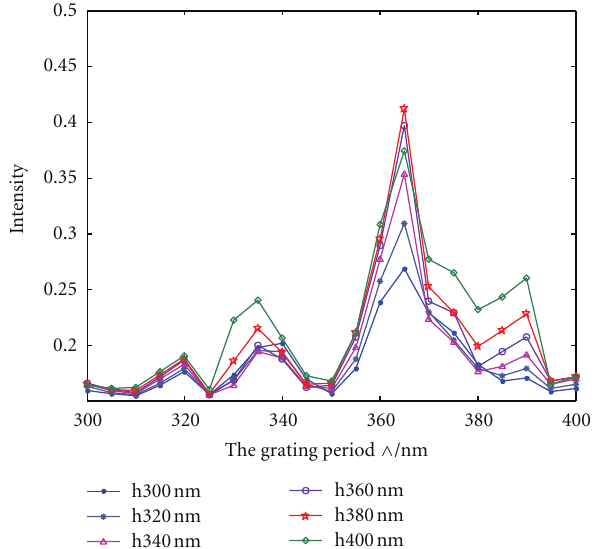
Figure 5: Relationship between the grating period of GaN and light extraction e ffi ciency with silver film thickness ranging from 300 nm to 400nm.